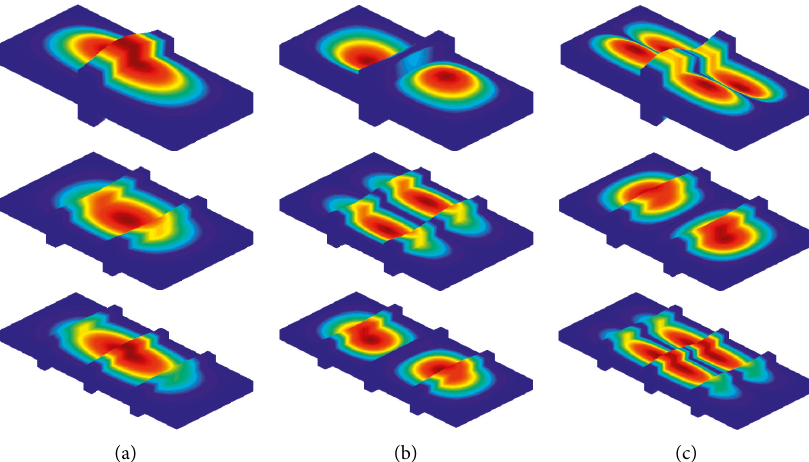
Figure 10: Some mode shapes of multi-stepped FG-CNTRC plate with CCCC boundary condition (FG-V, V ∗ η 2 =1.585, η 3 =1.109). (a) Mode1. (b) Mode2. (c) Mode3.